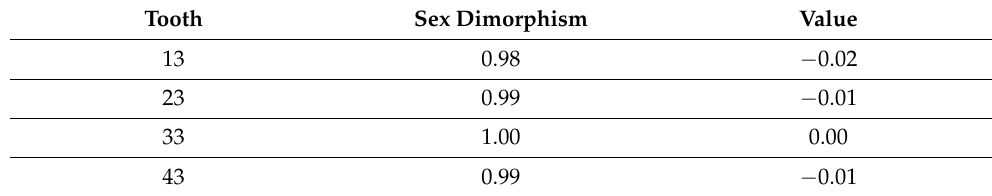
Table 6. Sex dimorphism value of permanent canines.